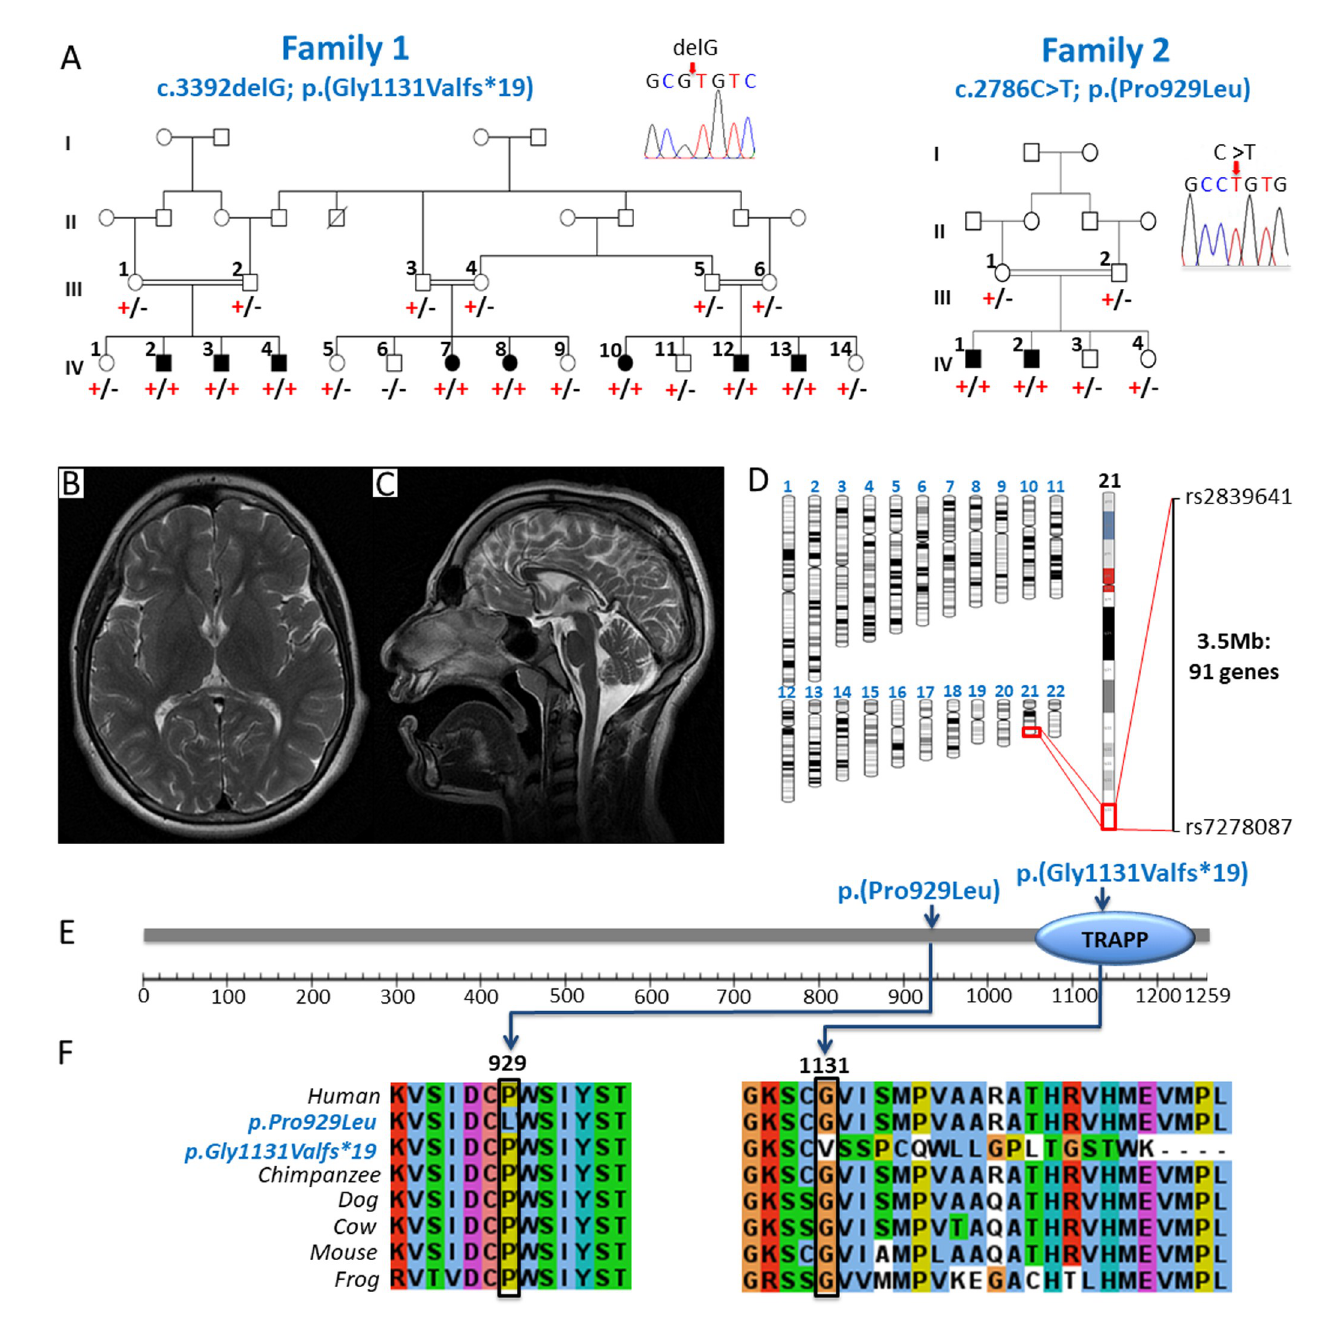
Fig 1. Biallelic TRAPPC10 variants identified in two families with individuals affected by a microcephalic neurodevelopmental disorder. ( A ) Family 1 Extended pedigree comprising three interlinking families and a total of eight affected individuals all of whom are homozygous for the TRAPPC10 c.3392delG; p.(Gly1131Valfs � 19) variant (‘+’), with co-segregation confirmed in other family members (‘-’ indicates the wild type allele). Inset: Dideoxy sequence chromatogram of an affected individual homozygous for the TRAPPC10 c.3392delG; p.(Gly1131Valfs � 19) variant. Family 2 Previously reported family (MR107) [27] showing co-segregation of the TRAPPC10 c.2786C > T; p.(Pro929Leu) variant (‘+’) in a four generation pedigree (‘-’ indicates the wild type allele). Inset: Dideoxy sequence chromatogram of an affected individual homozygous for the TRAPPC10 c.2786C > T; p.(Pro929Leu) variant. ( B, C ) MRI neuroimaging of individual IV:2 from family 1 demonstrates microcephaly and profound thinning of the corpus callosum with no other abnormalities. ( D ) Genome-wide SNP mapping in seven affected individuals (1-IV:2–4, 1-IV:7–8 and 1-IV:12– 13) identified a single (3.5Mb) region of shared homozygosity, containing 91 genes including TRAPPC10 . ( E ) Schematic diagram of the TRAPPC10 protein identifying TRAPPC10 sequence variants and TRAPP domain. ( F ) Multi-species alignment showing conservation of the molecular region encompassing the p.Gly1131Valfs � 19 and p.Pro929Leu variants.